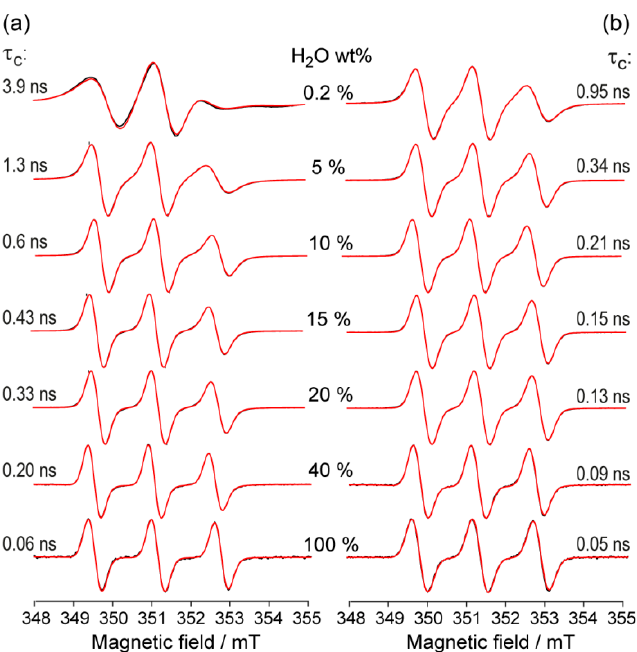
Figure 3. CW EPR spectra of K1 ( a ) and K2 ( b ) radicals dissolved in H 2 O/[Bmim]BF 4 mixtures with water concentration depicted (in wt%) at room temperature. Black curves show experimental data, red curves–simulation results. The values of τ c are shown for each spectrum. Other simulation parameters are given in Supplementary Materials.